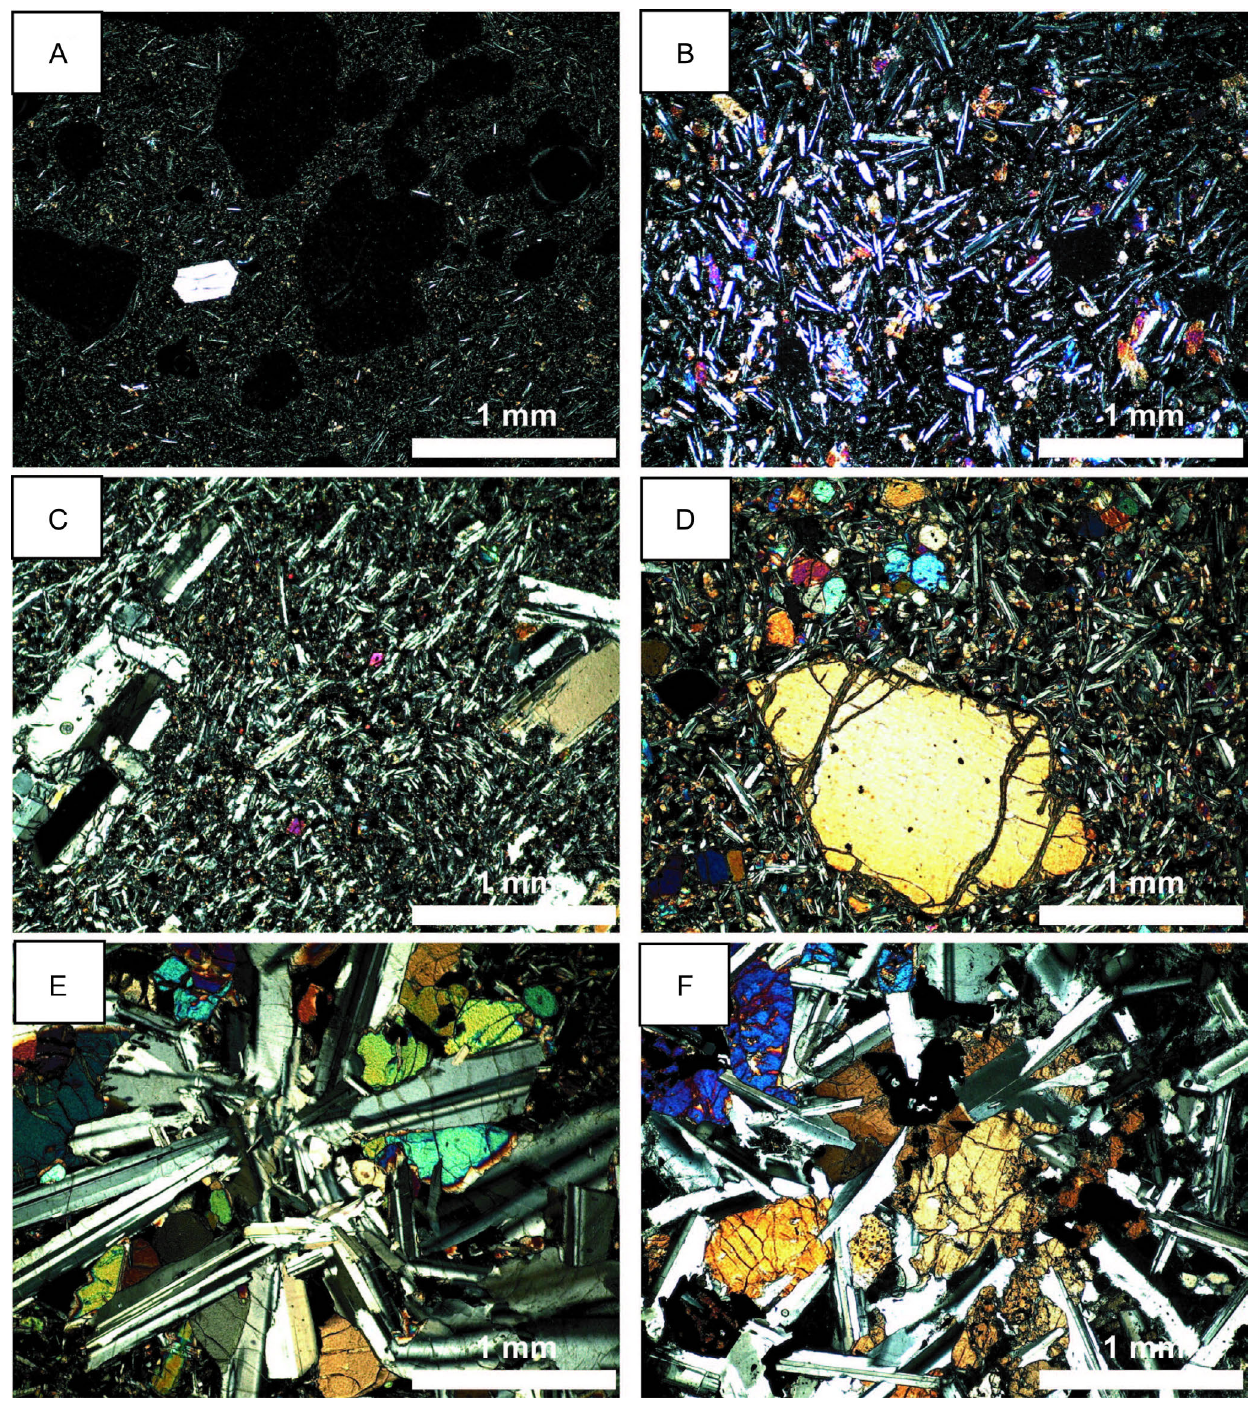
Figure 4: Thin section pictures of different sampled lithologies from La Réunion. [A] aphyric vesicular lava (sample B03); [B] fine-grained cotectic basalt from the July 2015 lava flow; [C] “Pintade” basalt with plagioclase phenocrysts (A03 sample); [D] olivine-basalt (PdN D1 dyke sample); [E] variolitic micro-troctolite (sample B05); [F] medium grained gabbro (sample